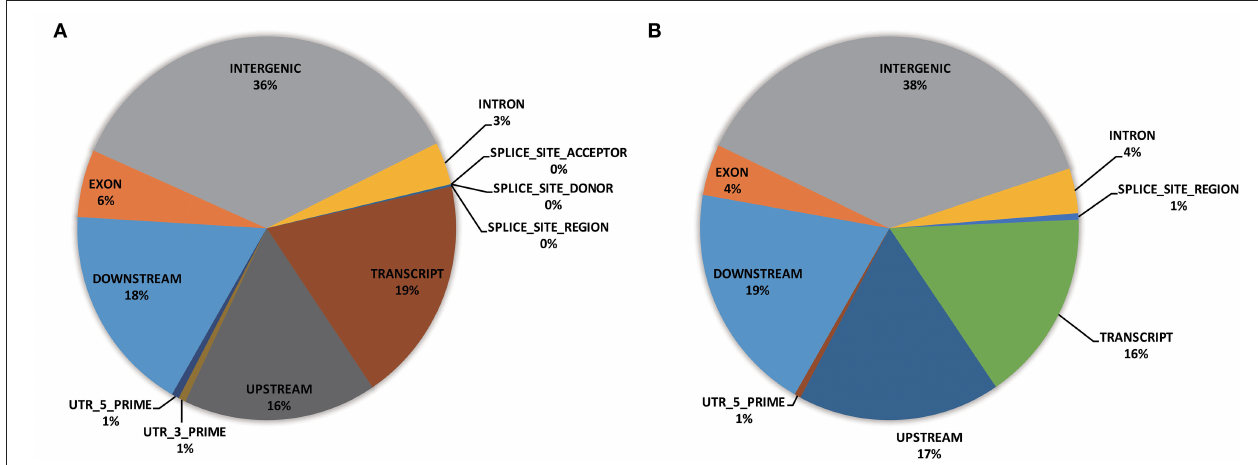
FIGURE 6 | Pie charts depicting genomic annotation for whole-genome GBS-SNPs (18,859 SNPs) (A) and significant GBS SNPs identified by EigenGWAS (83 GBS-SNPs) (B)